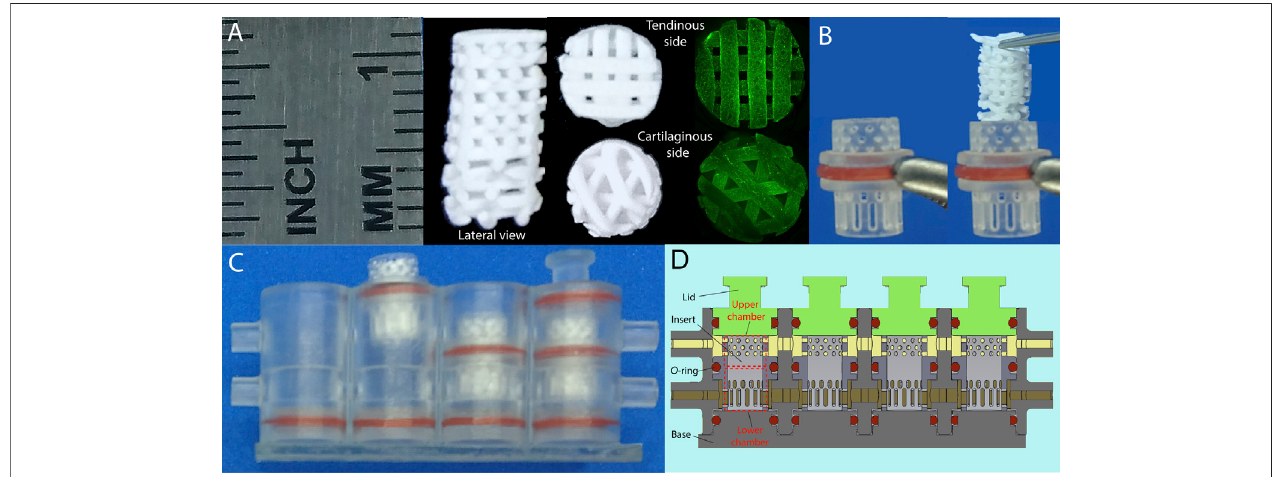
FIGURE 1 | (A) Macroscopic scaffolds appearance before cell seeding (white) and at day 7 after seeding (green fl uorescence based on FITC-phalloidin staining, high resolution images available as SI, Supplementary Figures S1, S2 ). (B) scaffold placement within insert, and (C) phases of bioreactor assembly. (D) Schematic representation of a bioreactor